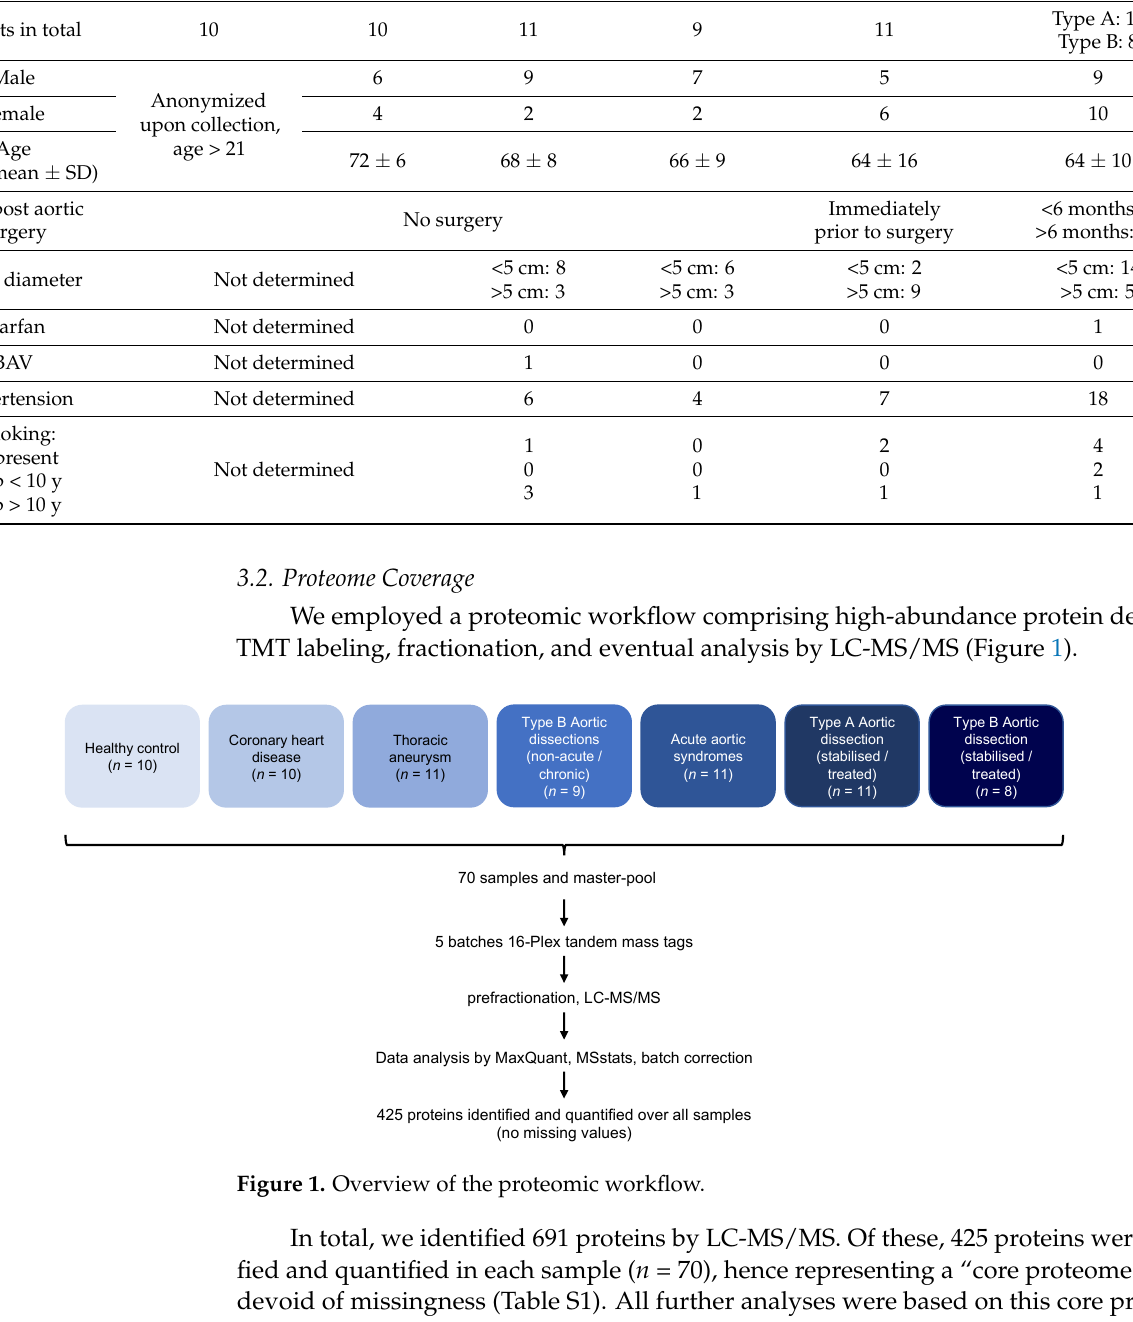
Table 1. Description of patient cohort for the serum proteome study. CHD (coronary heart disease); BAV (bicuspid aortic valve); y (years).